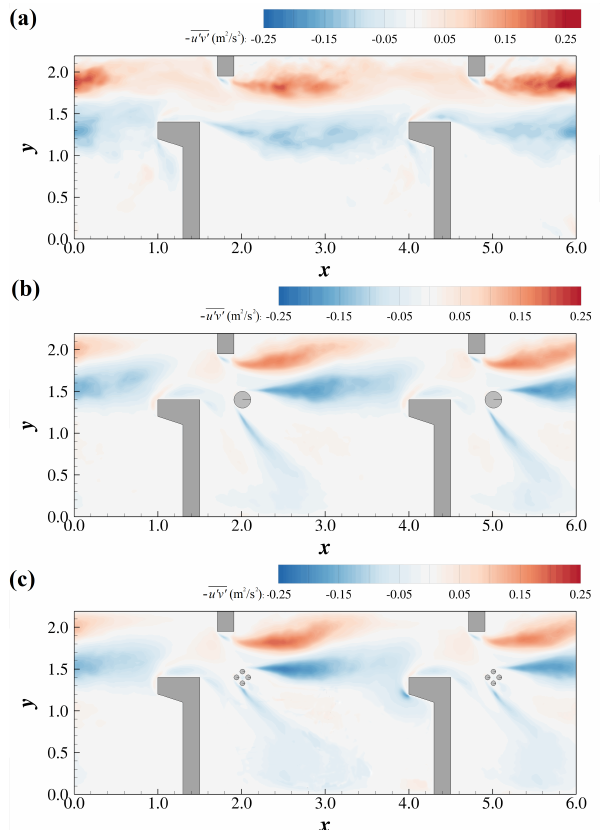
Figure 6. Contours of primary shear stress in a the horizontal plane at the half height of: ( a ) Case 1; ( b ) Case 2; ( c ) Case